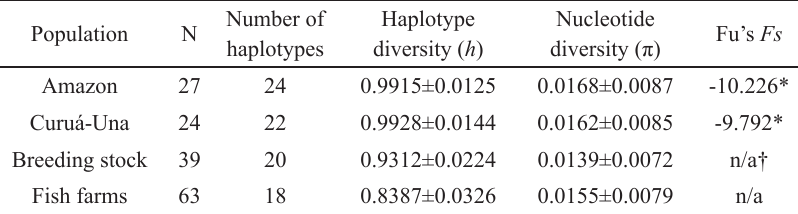
Indices of diversity for the mtDNA Control Region of the wild and captive C. macropomum populations analyzed in the present study.